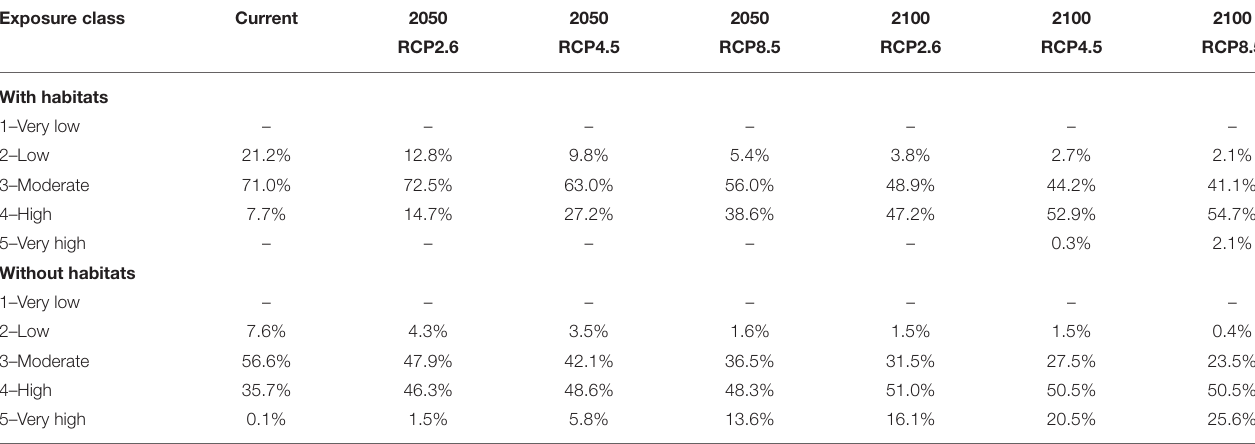
TABLE 1 | Percentage distribution of Exposure Index values across the different RCP scenarios, and with and without habitats scenarios, across the NW of Portugal. Exposure